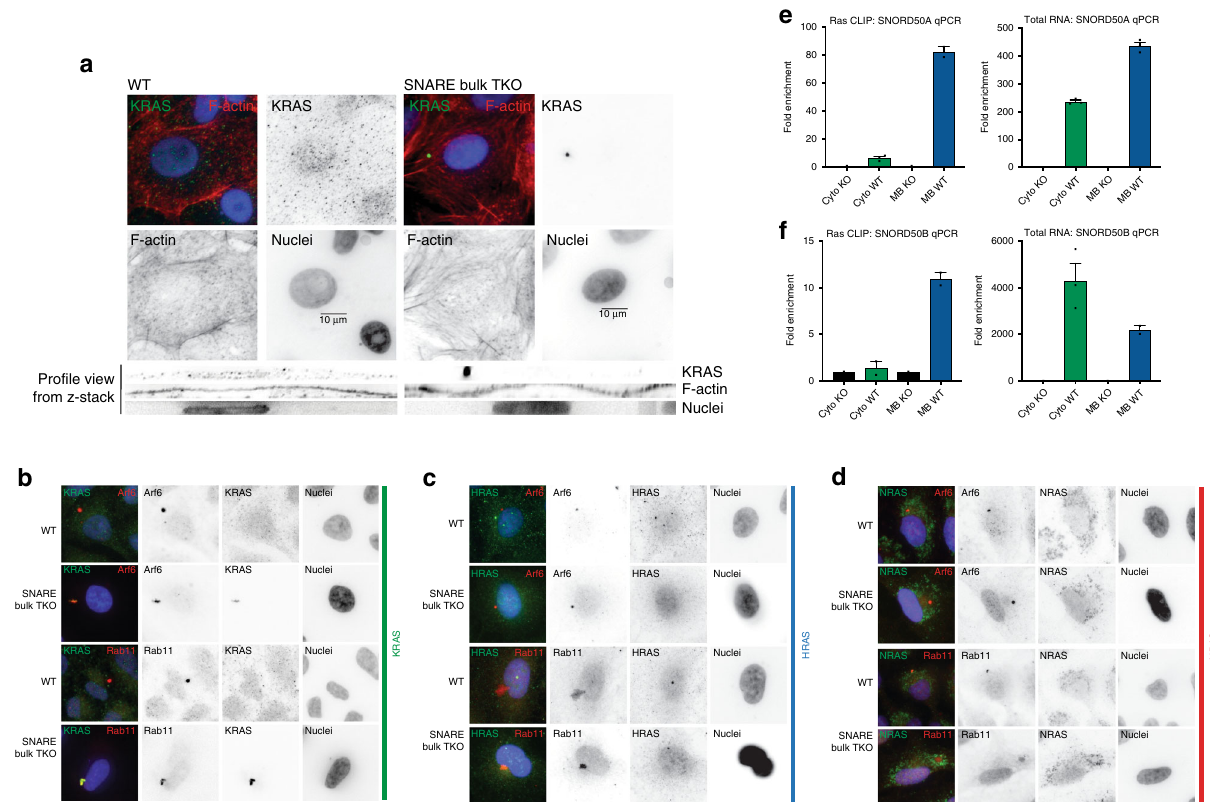
Fig. 4 SNARE deletion leads to KRAS localization in the recycling endosome. a Immuno fl uorescence of endogenous KRAS in A549 cells. Side pro fi le view of each cell (below); note KRAS localization at the PM with cortical actin and its re-localization to a perinuclear focus with SNARE TKO. Scale bars are 10 µ m. b KRAS colocalization with the recycling endosome markers, Arf6 and Rab11 as a function of SNARE TKO in A549. c HRAS and d NRAS colocalization with Arf6 and Rab11 as a function of SNARE TKO in A549. e CLIP-qPCR against SNORD50A and f SNORD50B after immunoprecipitation of endogenous RAS in either cytoplasmic or membrane bound subcellular fractions (left) from H23. qPCR against SNORD50A and SNORD50B in total RNA isolated from cytoplasmic or membrane bound fractions (right) from SNORD50A/B WT or KO cells from H23. Error bars are SNARE proteins are essential for downstream KRAS signaling .